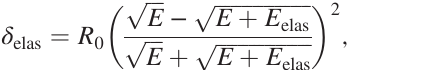
FIG. 1. Secondary electron yield curves of copper with δ 1 . 7 at E ¼ 332 eV and alumina with δ max 600 eV